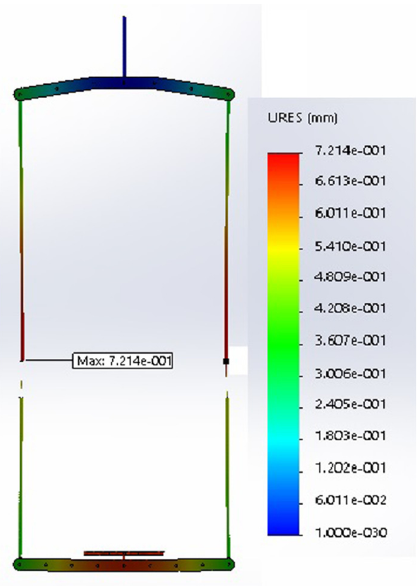
Fig. 7. The deformation distribution for the developed weighing pan.